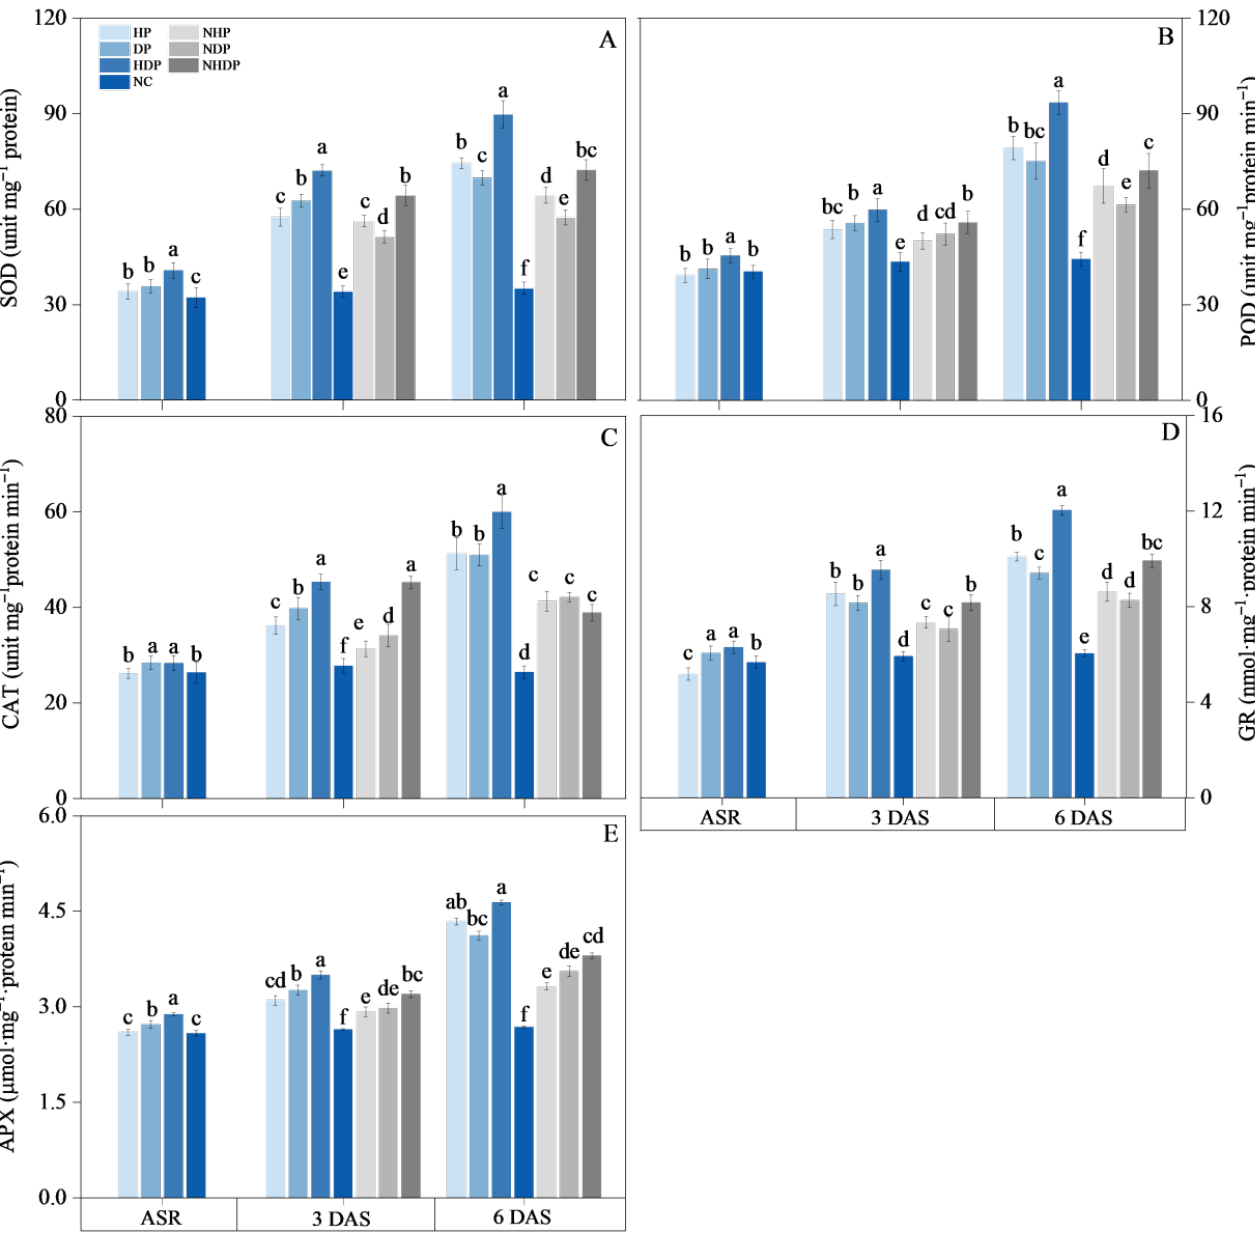
Figure 6. Effects of stress priming on superoxide dismutase (SOD, A ), peroxidase (POD, B ), catalase (CAT, C ), glutathione reductase (GR, D ), and ascorbate peroxidase (APX, E ) activities of seedlings under stress conditions. HP, heat priming + later heat stress; DP, drought priming + later drought stress; HDP, combined stress priming + later combined stress; NHP, no heat priming + later heat stress; NDP, no drought priming + later drought stress; NHDP, no combined stress priming + later combined stress; NC, no stress priming + no later stress. The bars represent means ± SD (n = 5), where different letters designate significant differences at the 0.05 level.